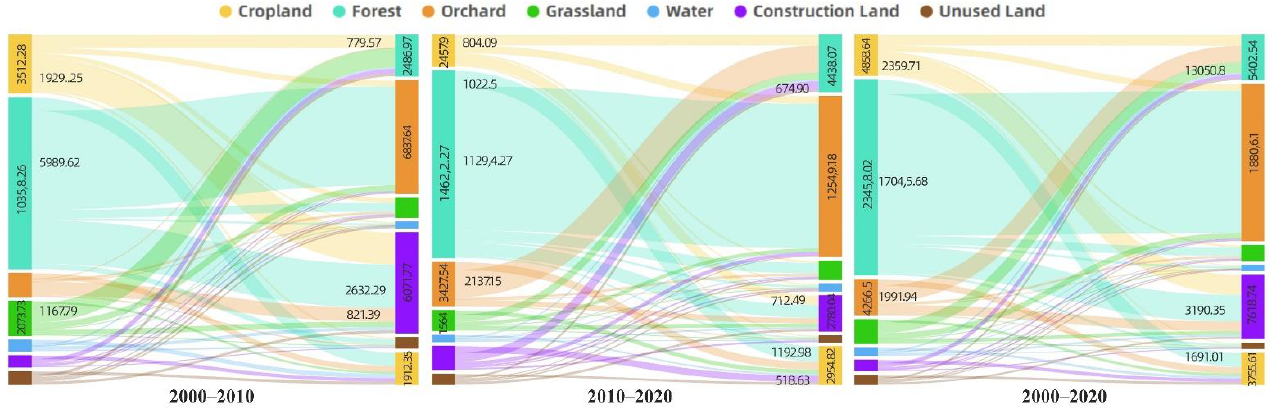
Figure 5. Land use transfer Sankey map.